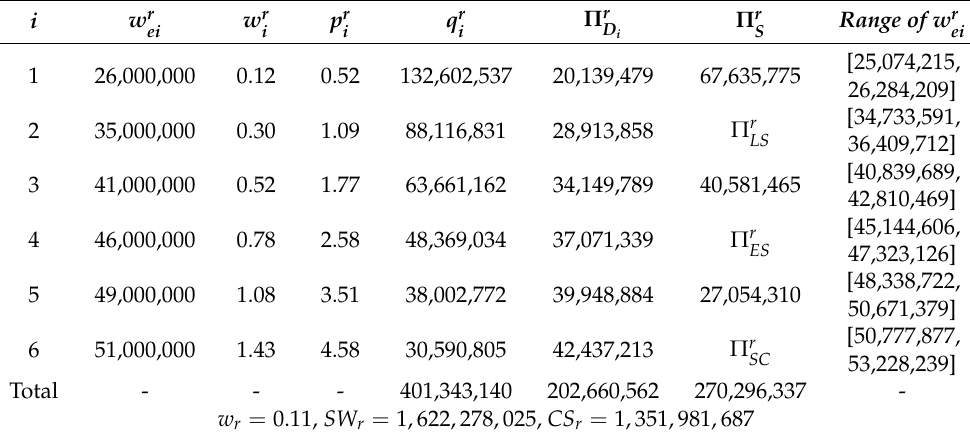
Table 6. Numerical Analysis Results of IBWT Supply Chain Coordination with Ramsey